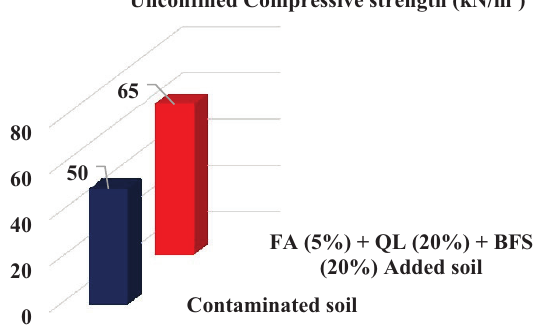
Figure 7. PLAXIS TM 3D model generated mesh diagram of the embankment (1 V: 1.5 H)